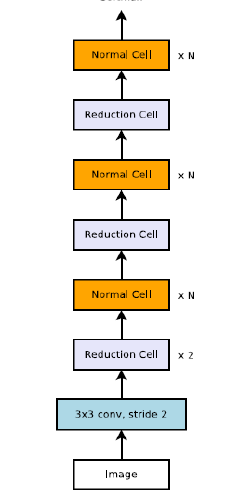
Figure 13. Layers of